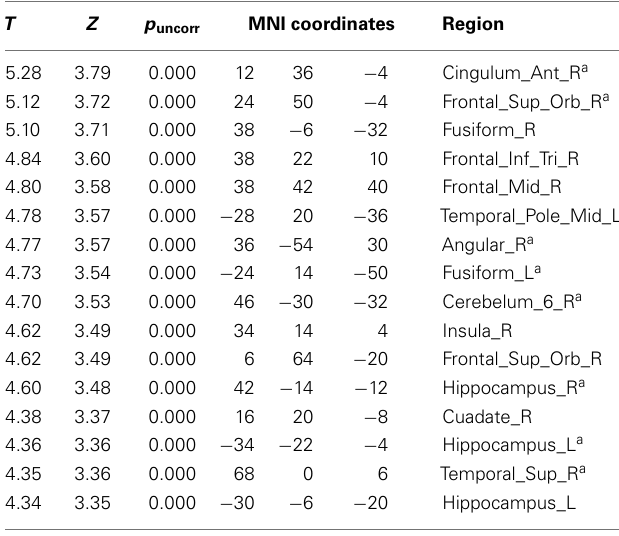
Table 2 | SPM analysis of cluster-level differences between patients with MS and healthy controls